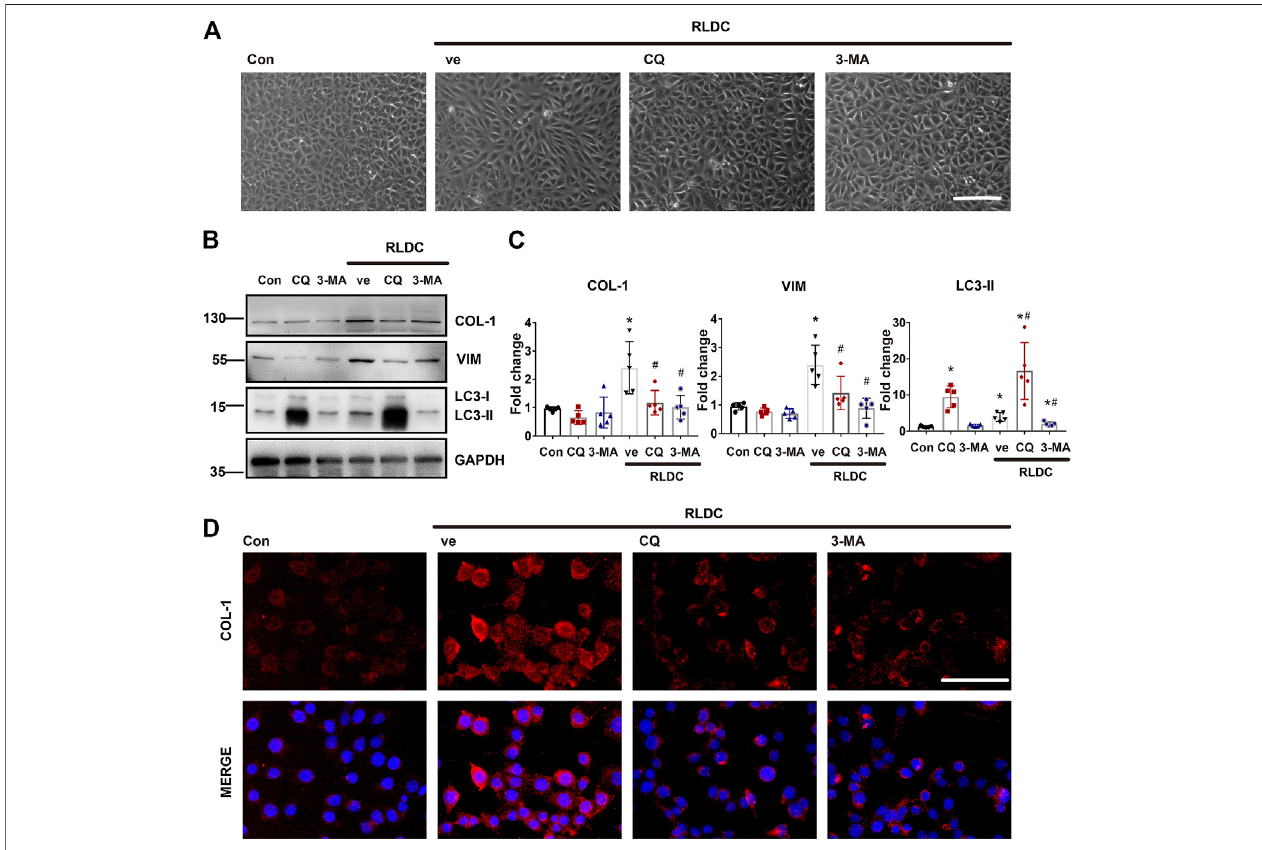
FIGURE5| Inhibitionofautophagysuppresses fi broticphenotypechangesinRLDC-treatedBUMPTcells.BUMPTcellswereincubatedwith2 μ Mcisplatinfor7 h each day for 4 days (RLDC) or without cisplatin exposure (Con). After the last 7 h of cisplatin treatment, cells were incubated with 20 μ M chloroquine (CQ) or 10 mM 3- methyladenine (3-MA) for 17 h in cisplatin-free medium. Cells were collected for morphological observation or biochemical analyses. (A) Cell morphology under light microscopeafterRLDCinductionwithorwithoutCQand3-MA.(bar=50 μ m). (B) RepresentativeimmunoblotsofCOL-1,VIM,LC3-I,LC3-IIandGAPDH(loading control).( n =5). (C) DensitometryofCOL-1,VIM,andLC3-II.TheexperimentswerenormalizedaccordingtoGAPDHexpression.Theproteinlevelofcontrolgroup(Con) wasarbitrarilysetas1,andthesignalsofotherconditionswerenormalizedwiththecontrolgrouptoindicatetheirproteinfoldchanges. (D) Immuno fl uorescenceofCOL- 1. (n = 5, bar = 50 μ m). Quantitative data are expressed as mean ± SEM. * p < 0.05 vs the control group (Con). # p < 0.05 vs. (RLDC + vehicle)